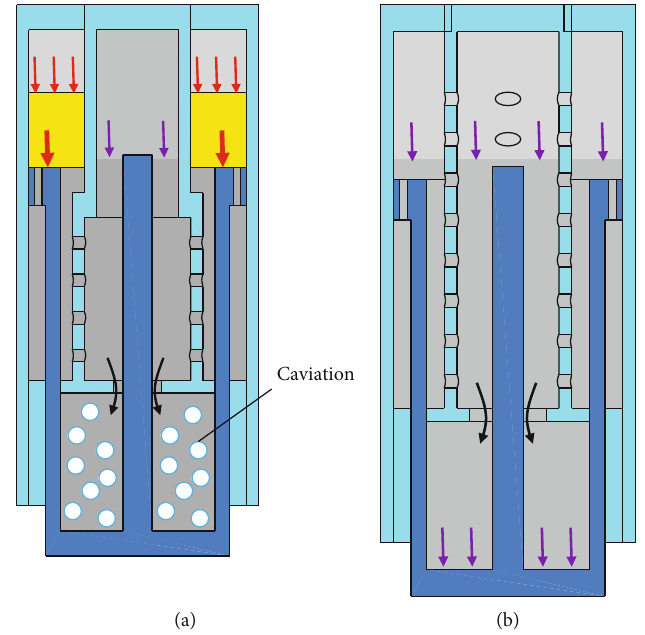
Figure 2: Force analysis of shock